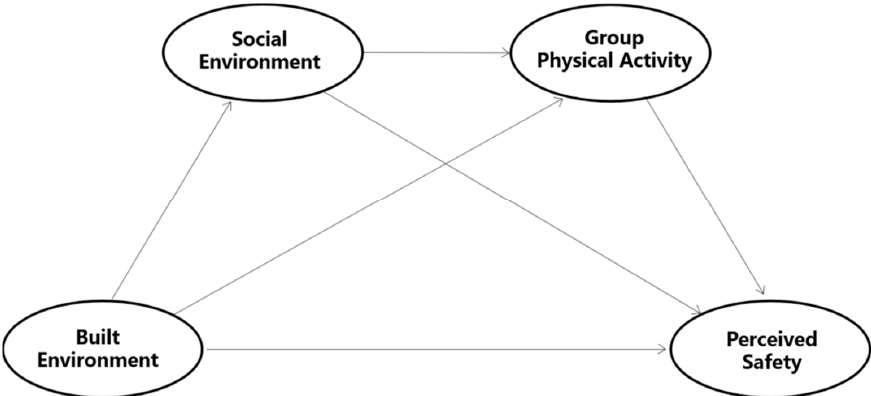
Figure 2. Complete framework: the integrated relationship between determinants and perceived safety with